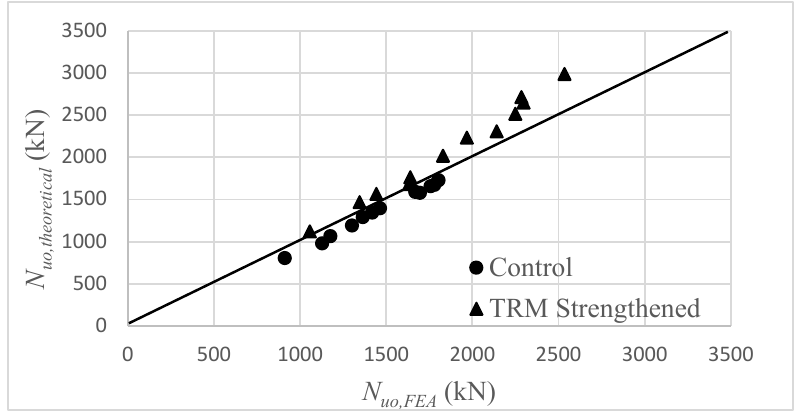
Figure 13. Comparison of FEA and theoretical axial load capacities.